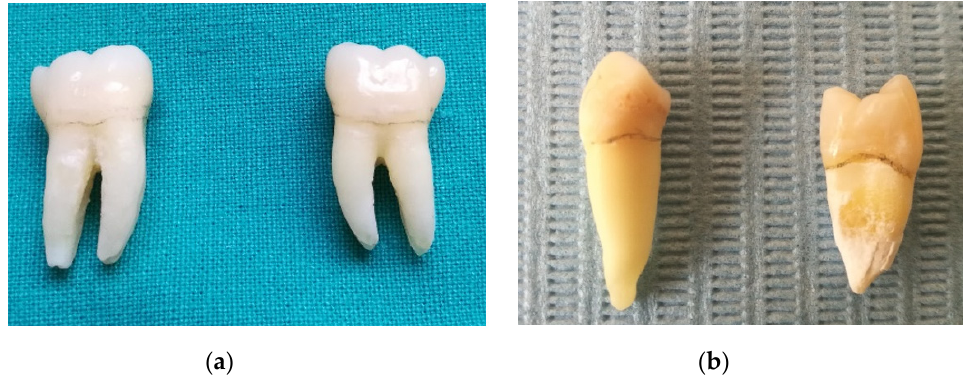
Figure 1. Samples 1, 2, 3, and 4 before shaping: ( a ) the mandibular molars; ( b ) the mandibular premolars. The finish line of the preparation was performed. A proper reduction cut of the axial surfaces using a 1.5 mm round bur was made, then, the margins of cervical preparation were made using a truncated bur (green ring) at the amelioration-cement junction (CEJ). The occlusal surfaces have been reduced with a bur football (green ring) (Figure